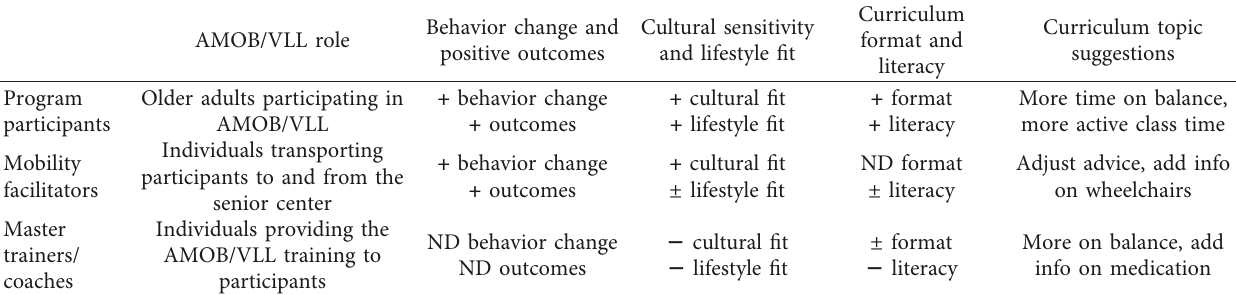
Table 2: Primary discussion points for each discussion category by participant groups.